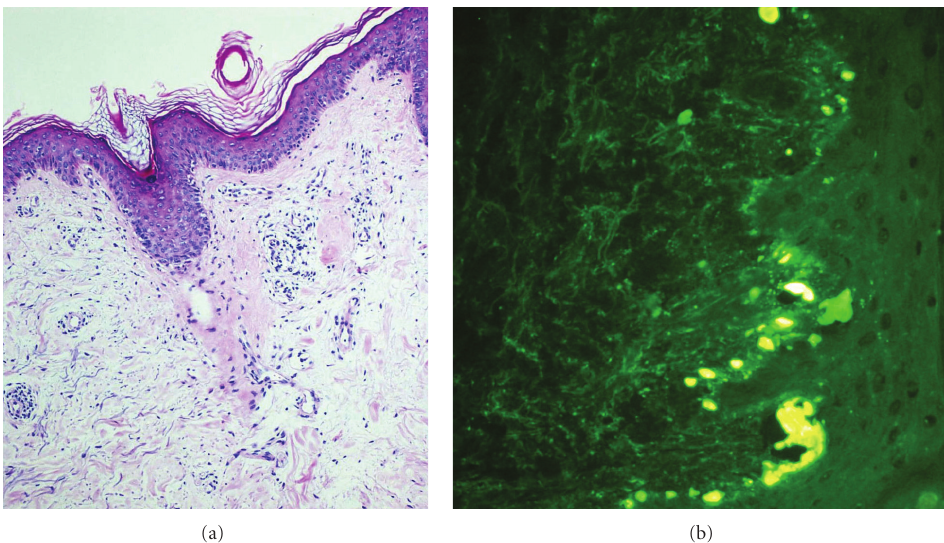
Figure 3: (a) Superficial perivascular dermatitis; basket-weave hyperkeratosis through the epidermis, slight atrophy, vacuolar degeneration of the basal lamina, papillary dermal oedema, and perivascular lymphocytic infiltration (H&E × 200). (b) In the direct immunofluorescence examination, irregular staining groups for IgM and IgA were monitored at the tips of papillae of the basal lamina.